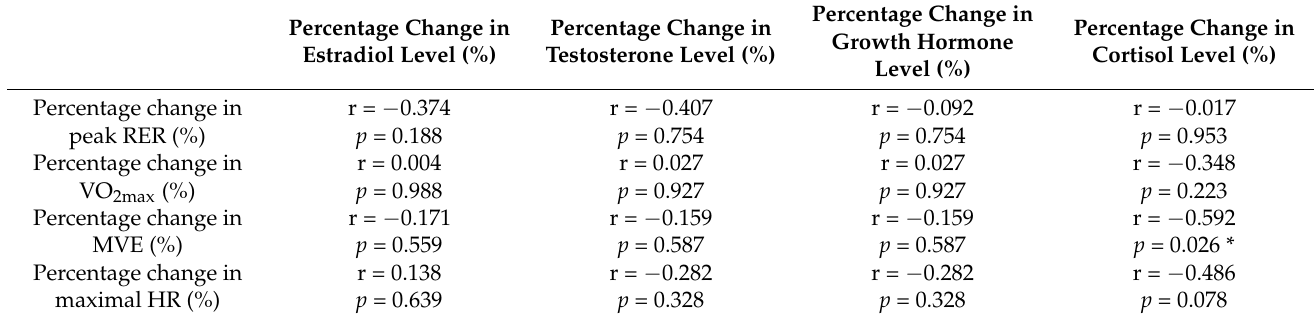
Table 4. Correlation between percentage changes in cardiorespiratory variables and blood hormonal